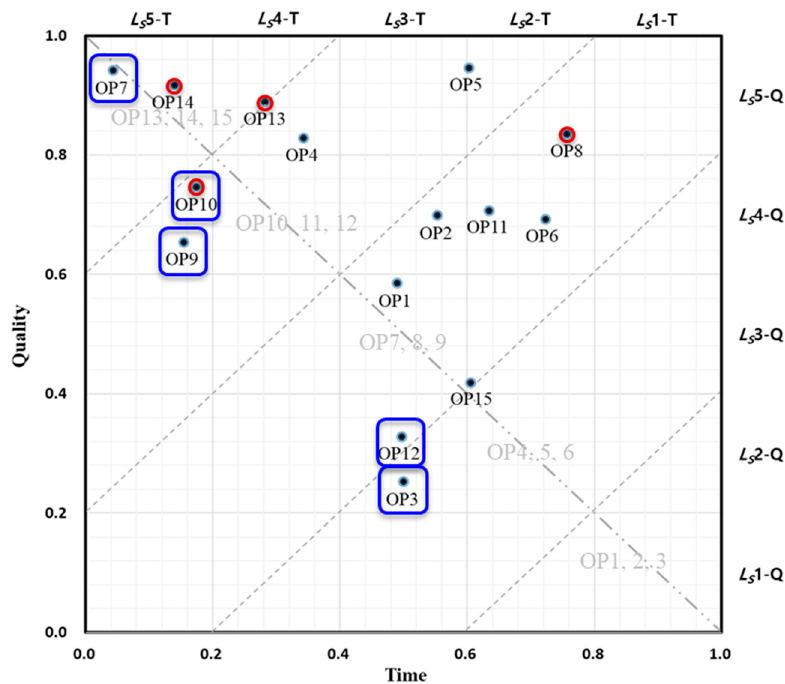
Figure 5. L S measurement results of individual operators.